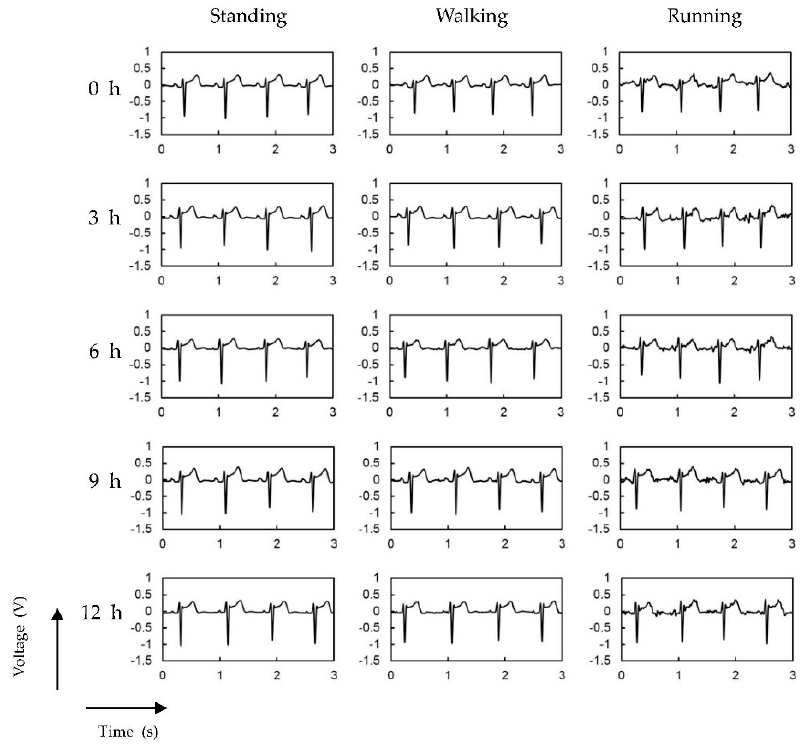
Figure 12. ECG signals measured every 3 h for 12 h after application of P-electrodes on skin.